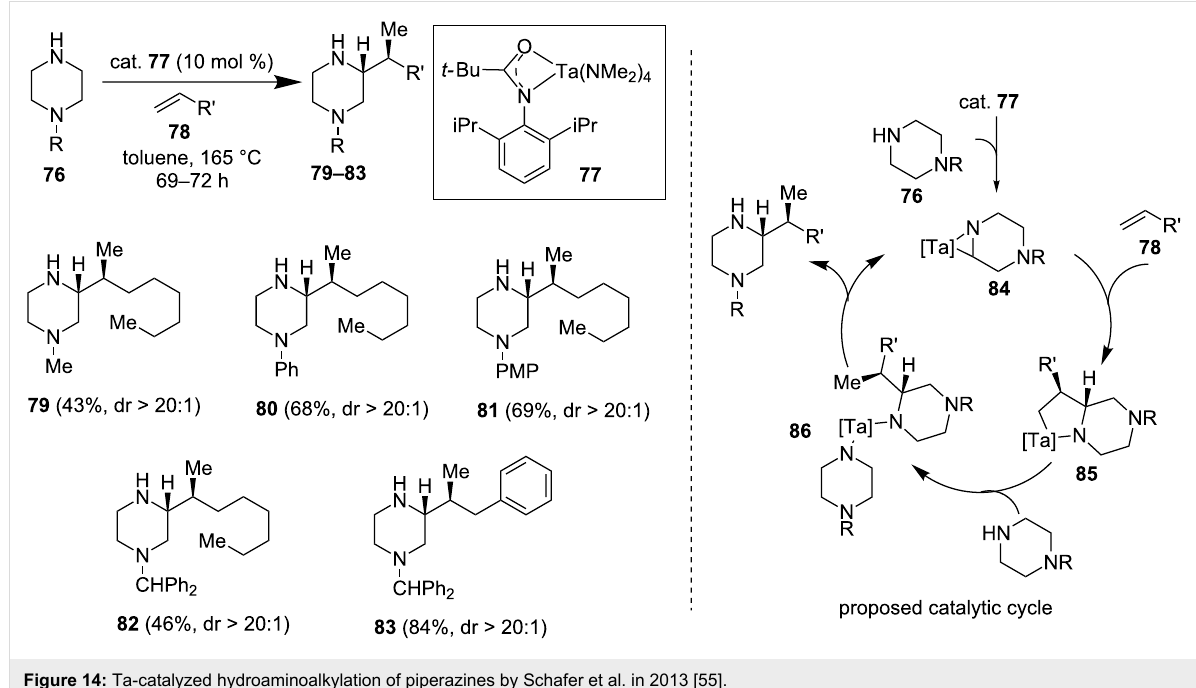
Figure 14: Ta-catalyzed hydroaminoalkylation of piperazines by Schafer et al. in 2013 [55].